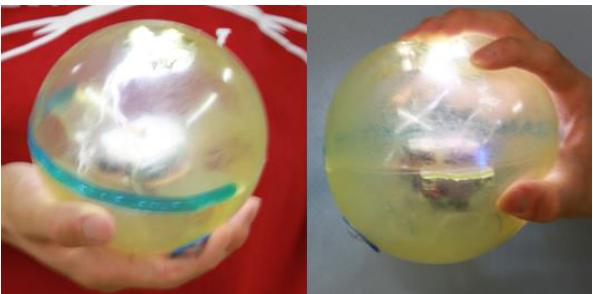
Figure 2. Grasping-type musical interface, TwinkleBall.